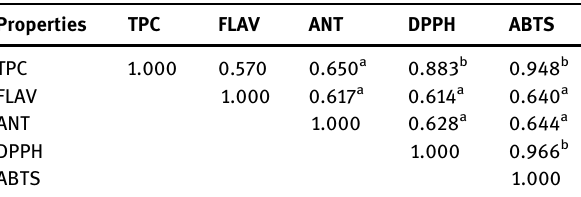
Table 3: Results of bivariate correlation analysis for Pearson correlation coe ffi cients